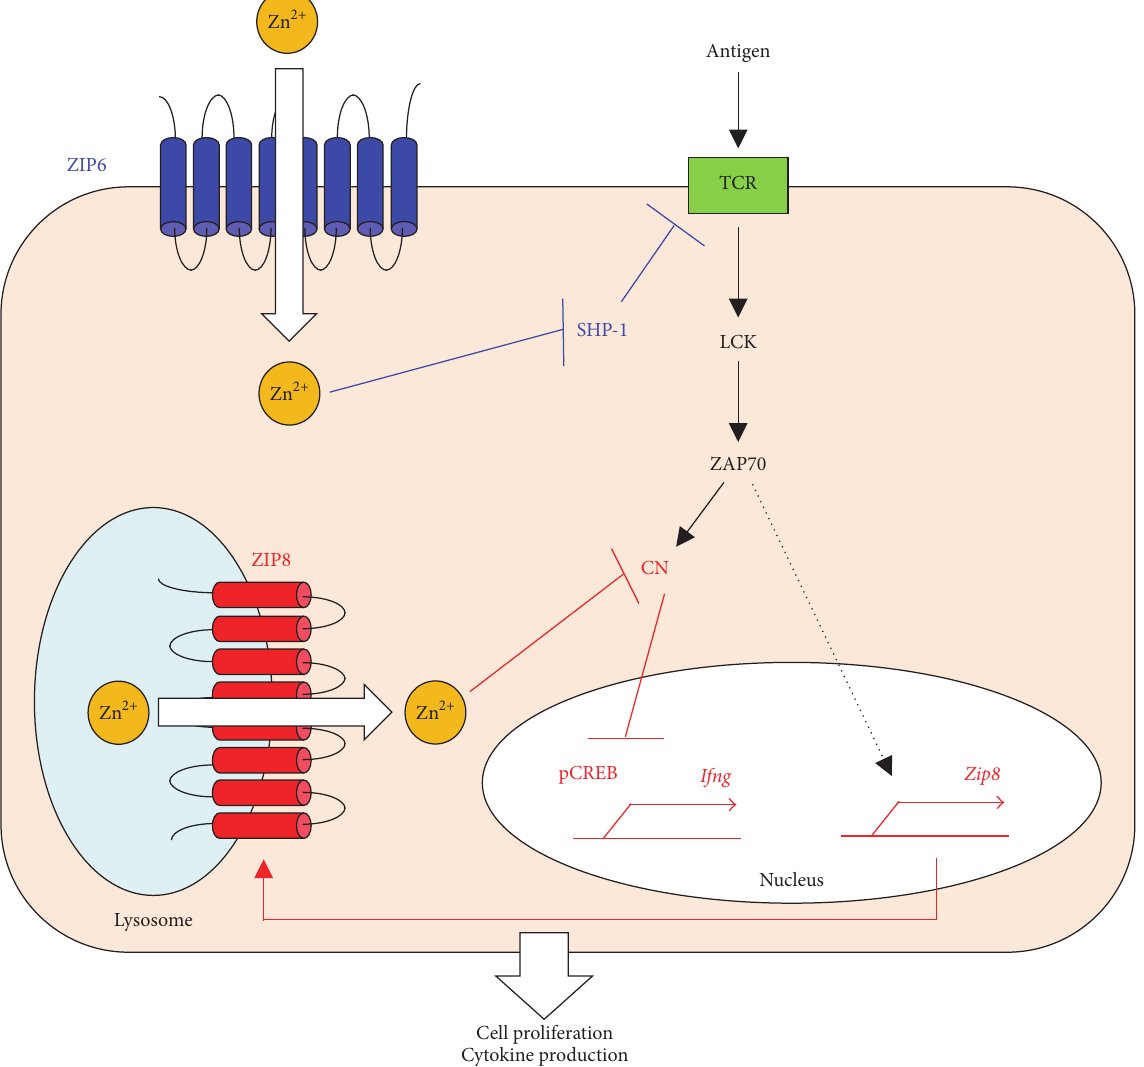
Figure 5: Zn uptake via ZIP6 and ZIP8 potentiates TCR signaling. Through the interaction of DCs and T cells, TCR activation rapidly increases cytoplasmic Zn concentrations, particularly at the subsynaptic compartment, in a manner dependent on ZIP6 (blue). The enhanced influxofZnreducesSHP-1recruitmenttotheTCRactivationcomplex,therebyaugmentingZAP70activationandleadingtoasustainedinflux of calcium. On the other hand, TCR activation increases ZIP8 expression, which exports Zn out of the lysosome and into the cytoplasm (red). The resultant increase in cytoplasmic Zn inhibits CN, leading to increased CREB activation and the subsequent expression of IFN- 𝛾 . Thus, Zn facilitates TCR’s functions in proliferation and IFN- 𝛾